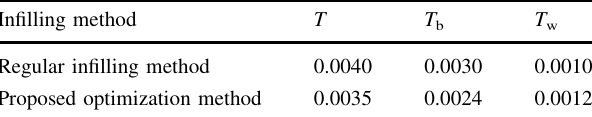
Table 3 Displacement balanced degree of different infilling method